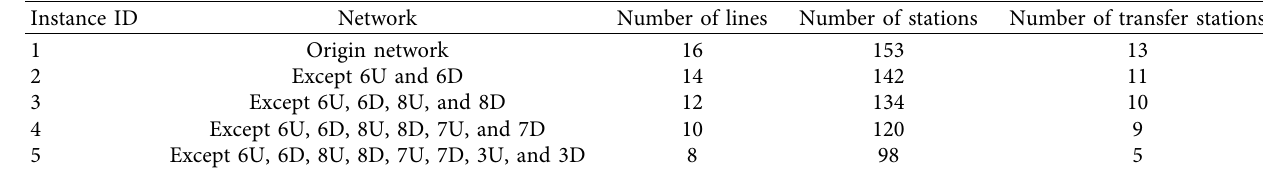
Table 8: Instance information.